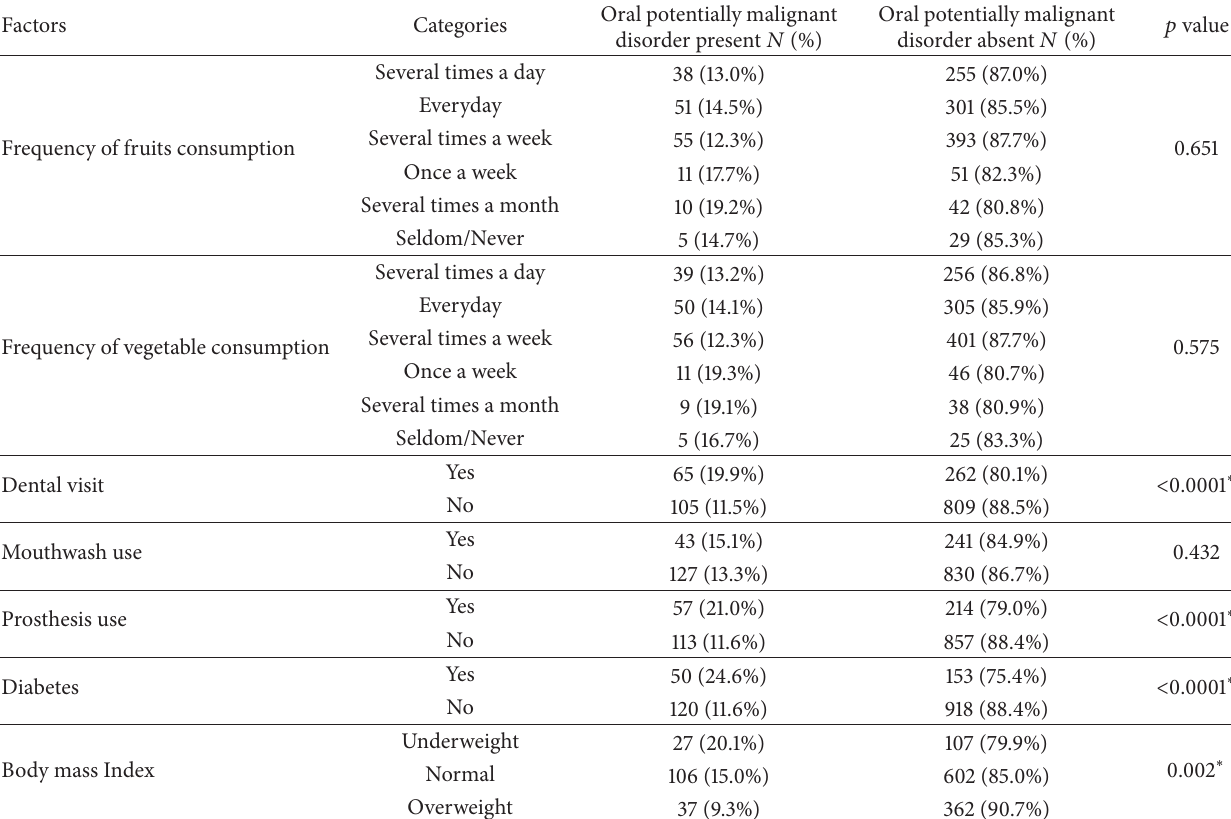
Table 4: Association of dietary and other risk factors with oral potentially malignant